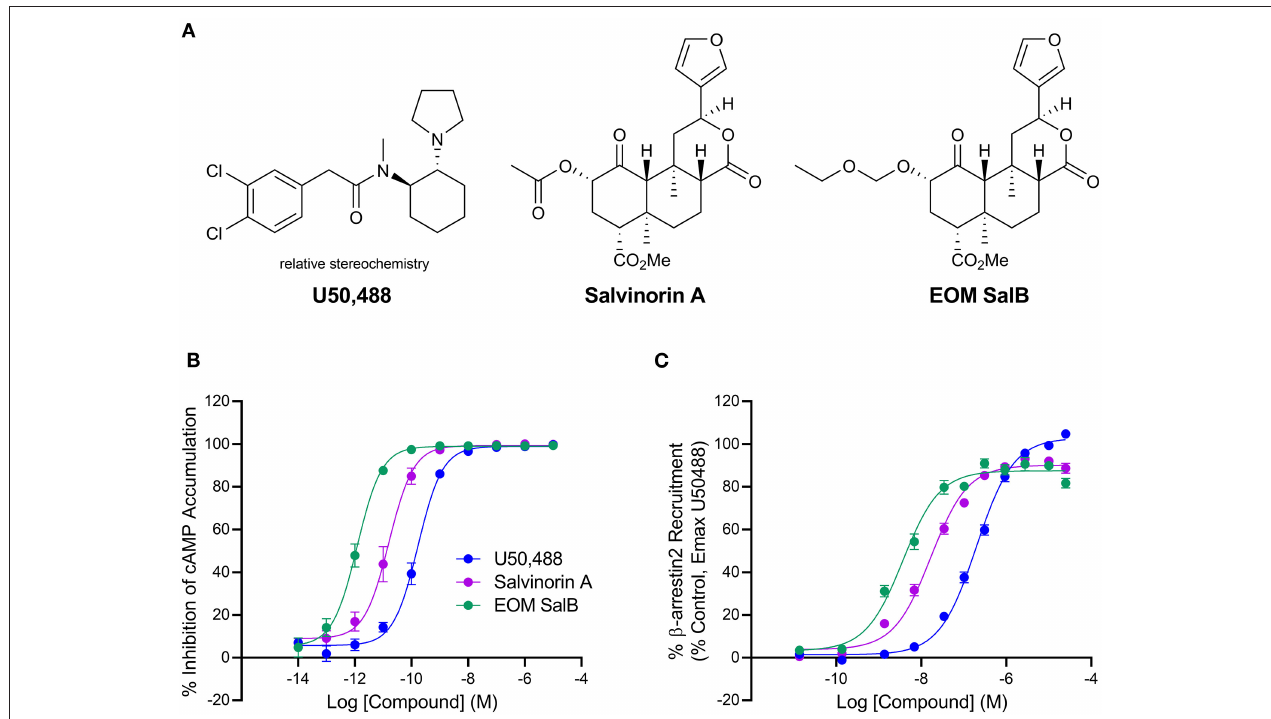
FIGURE 1 | Chemical structures and in vitro activity. (A) Chemical structures of U50,488, Salvinorin A, and EOM SalB. (B) The KOR agonists were measured for inhibition of forskolin-induced cyclic adenosine monophosphate (cAMP) using the HitHunter TM assay. (C) The β -arrestin2 signaling pathway was assessed using the